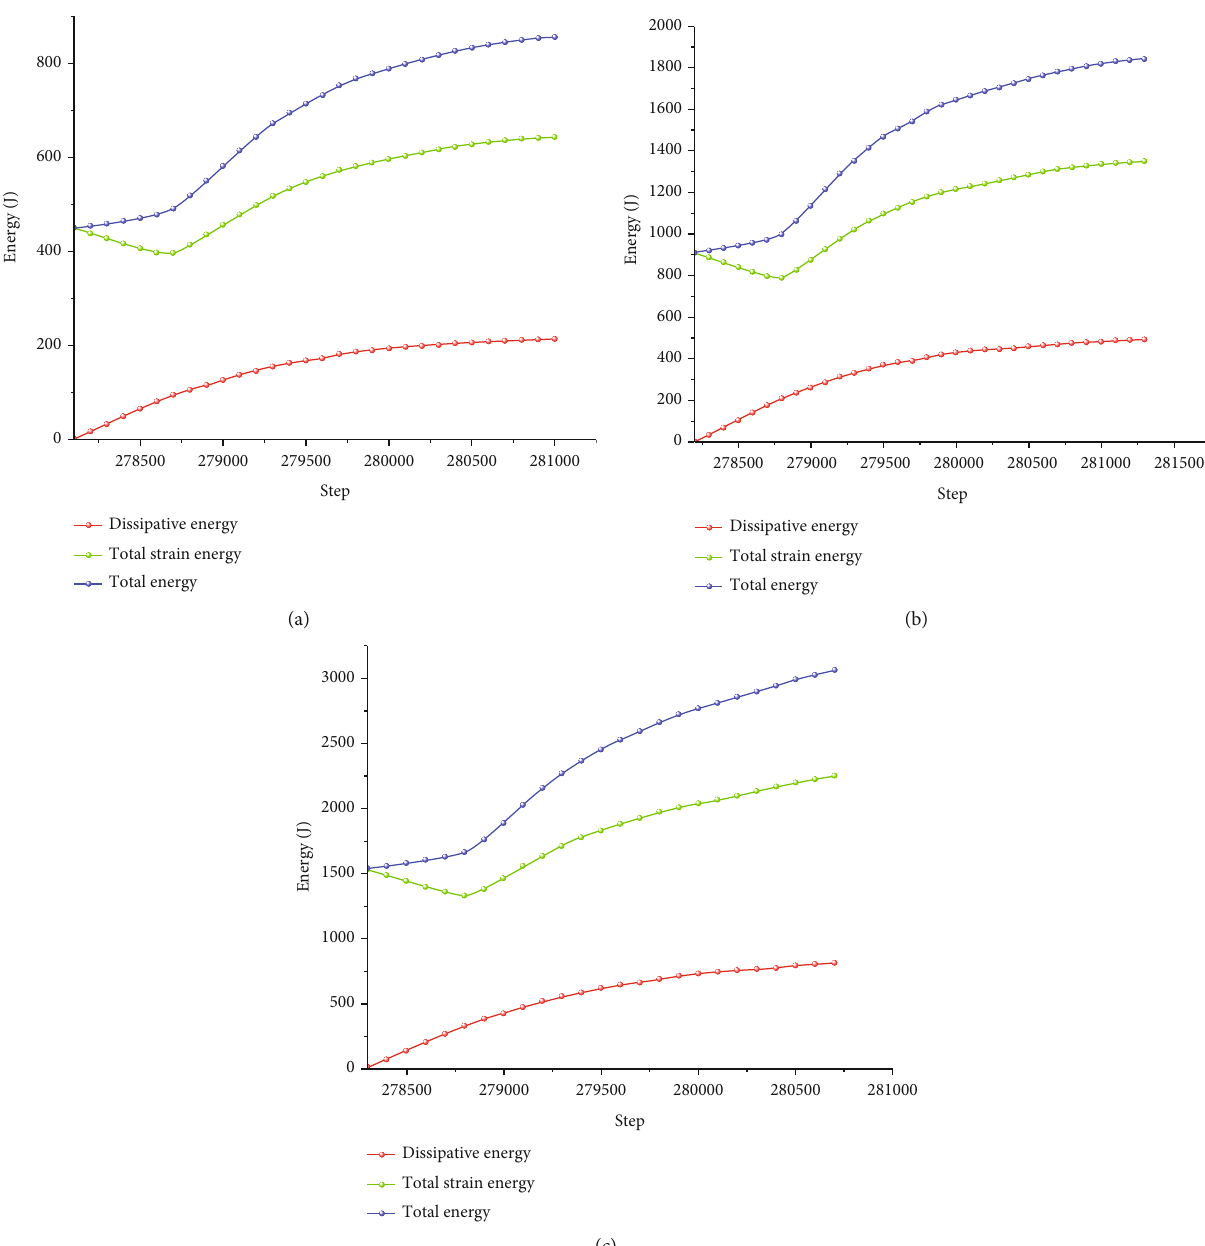
σ σ σ V = H = 40 MPa . (b) V = H = 60